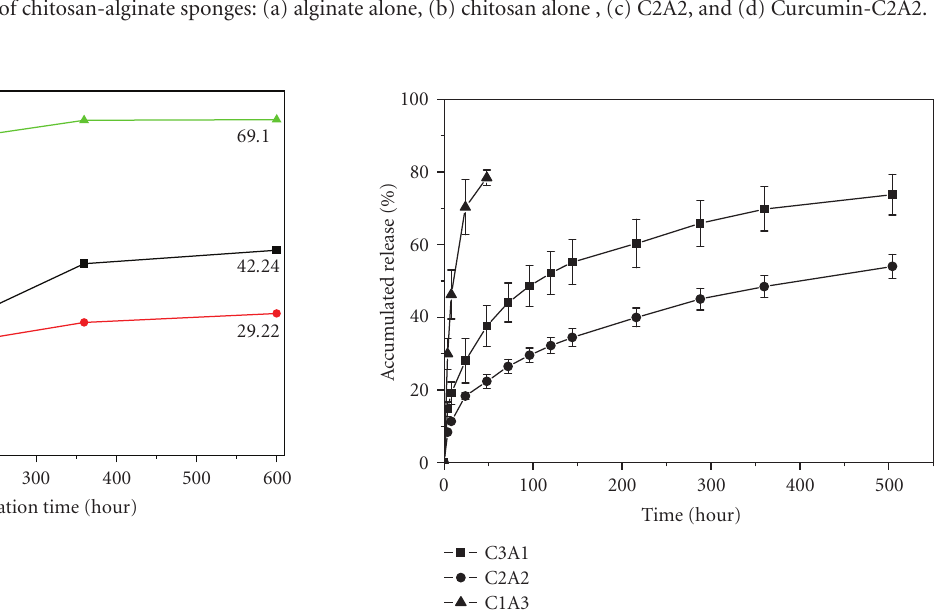
Figure 3: SEM micrographs of chitosan-alginate sponges: (a) alginate alone, (b) chitosan alone , (c) C2A2, and (d) Curcumin-C2A2.